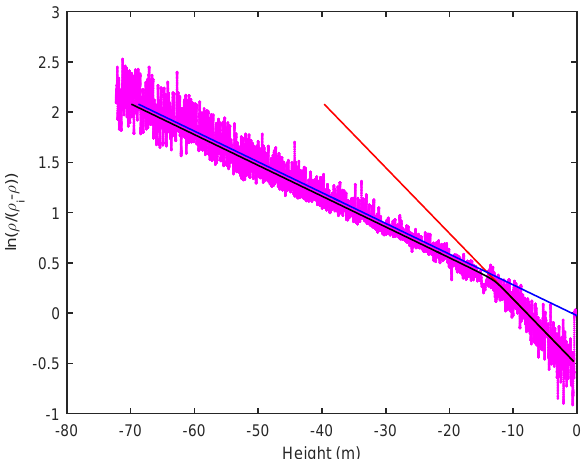
Figure 9. Profiles of ln( ρ / ( ρ i − ρ )) for ice core B26. Measured values (magenta line), modelled values using Herron and Langway Stage 1 (red) and Stage 2 (blue) densification rates, and modelled values using the transition model with ρ T = 530 kg m − 3 , M = 7 (black